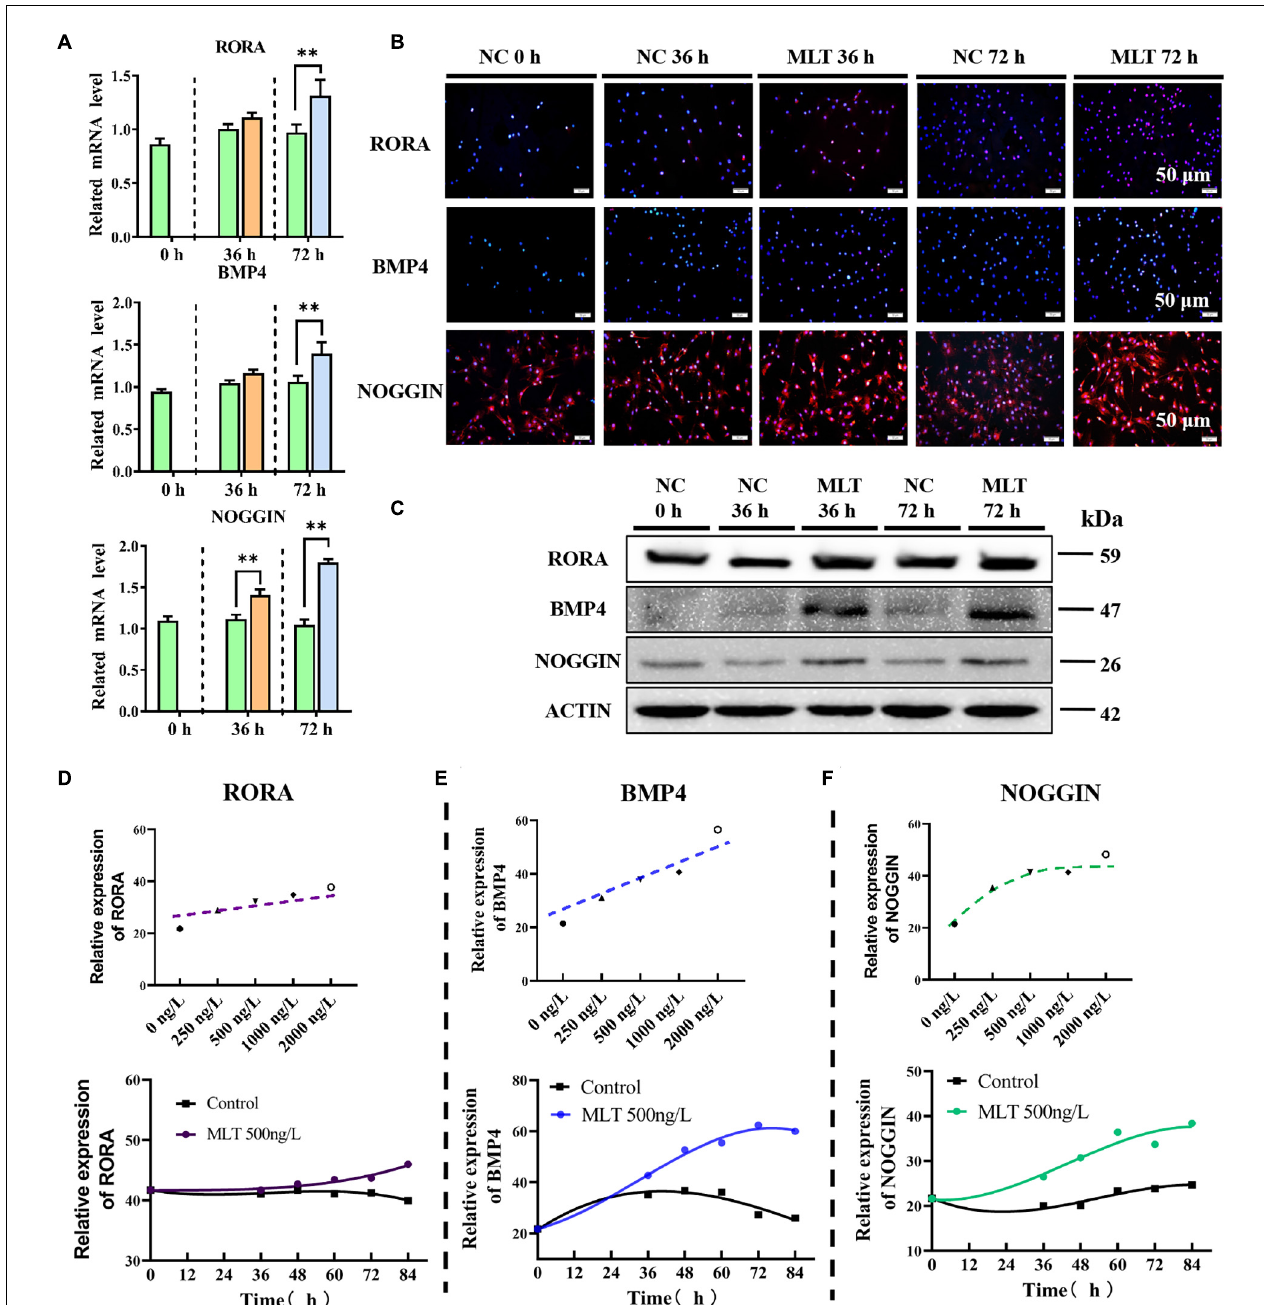
FIGURE 5 | Melatonin mediated the expression of ROR α , BMP4, and NOGGIN. (A) Relative mRNA levels of ROR α , BMP4, and NOGGIN in gsHFSCs before/after melatonin exposure (Control: green; 36 h melatonin: orange; 72 h melatonin: blue); ∗∗ p < 0.01. (B) Protein levels of ROR α , BMP4, and NOGGIN in gsHFSCs as revealed by immunofluorescence staining. Scale bar, 50 µ m. (C) Protein levels of ROR α , BMP4, and NOGGIN in gsHFSCs as shown by Western blotting. (D) Fluorescence intensity analysis of ROR α in melatonin exposed gsHFSCs. (E) Fluorescence intensity analysis of BMP4 in melatonin exposed gsHFSCs. (F) Fluorescence intensity of NOGGIN in melatonin exposed